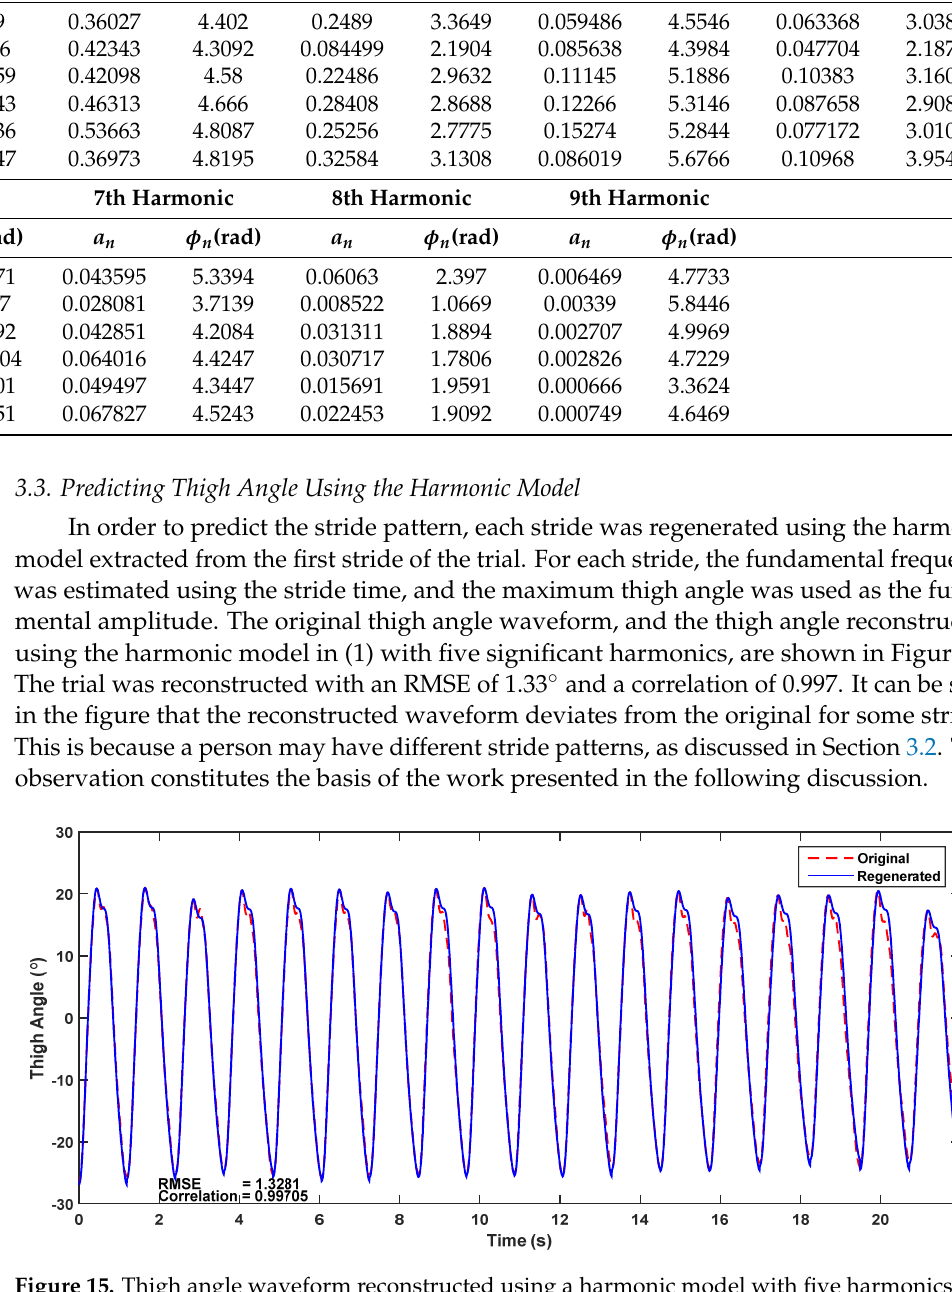
Figure 15. Thigh angle waveform reconstructed using a harmonic model with five harmonics and the original thigh angle waveform for a long walk.